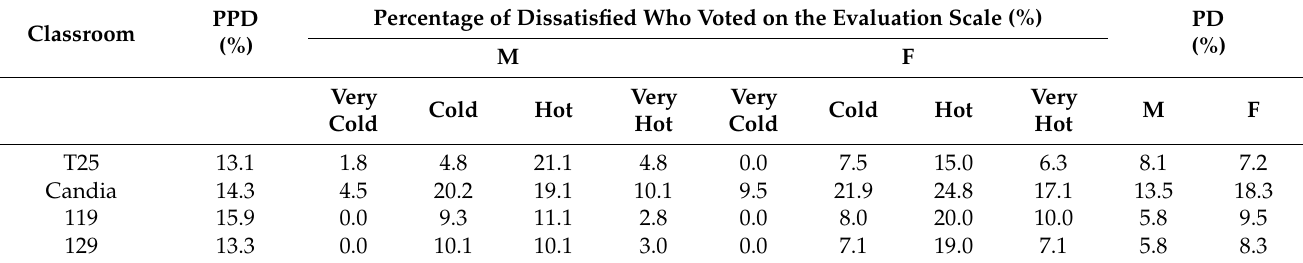
Table 5. Comparison between objective measurement and subjective survey. Legend: percentage of dissatisfied by subjective investigation (PD); predicted percentage of dissatisfied by objective measurement (PPD); females (F); males (M).